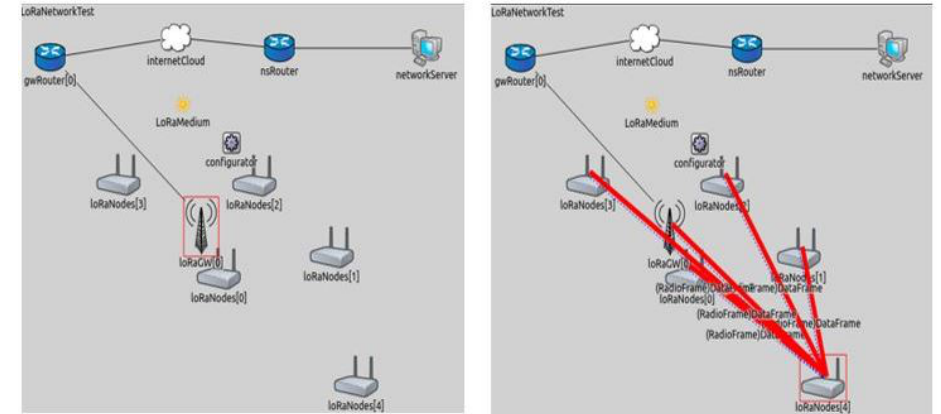
Figure 5. Framework for LoRa (FLoRa) graphical interface.